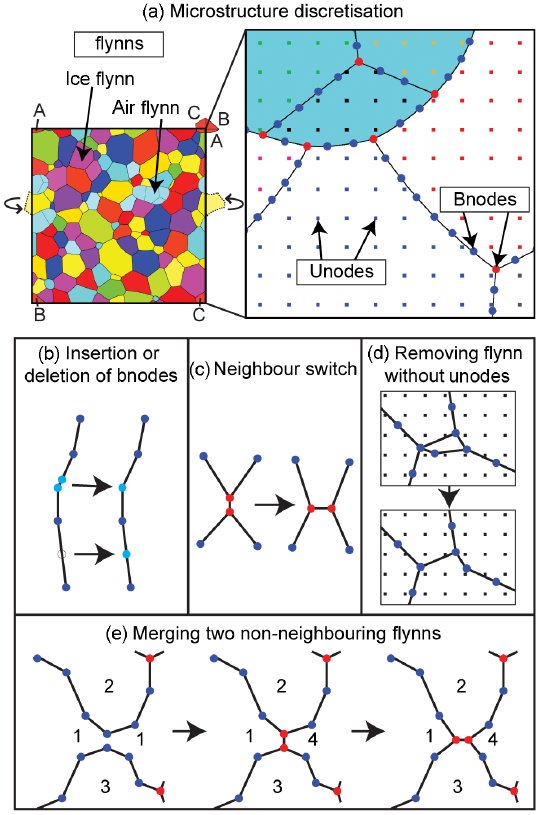
Figure 1. Microstructure discretization in Elle. (a) A contiguous set of polygons (flynns) is composed of boundary nodes (bnodes) and has periodic boundaries. An additional grid of unconnected nodes (unodes) is superimposed on flynns and bnodes to store intracrys- talline properties, state variables and track deformation. (b–e) Topo- logical checks performed to keeping topological restrictions in Elle. Checks (b) , (c) and (e) are based on minimum and maximum bnode separations. Check (d) removes extremely small flynns that con- tain no undoes or have areas smaller than the area enclosed by four neighbouring unodes by merging them to a neighbour of the same